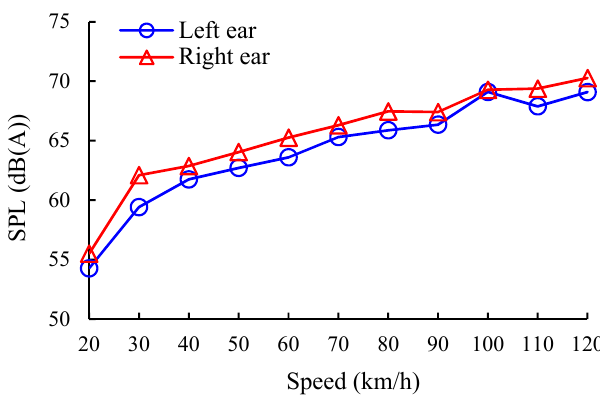
Figure 5. Interior noise sound pressure level (SPL) in the EV as a function of the vehicle’s speed.